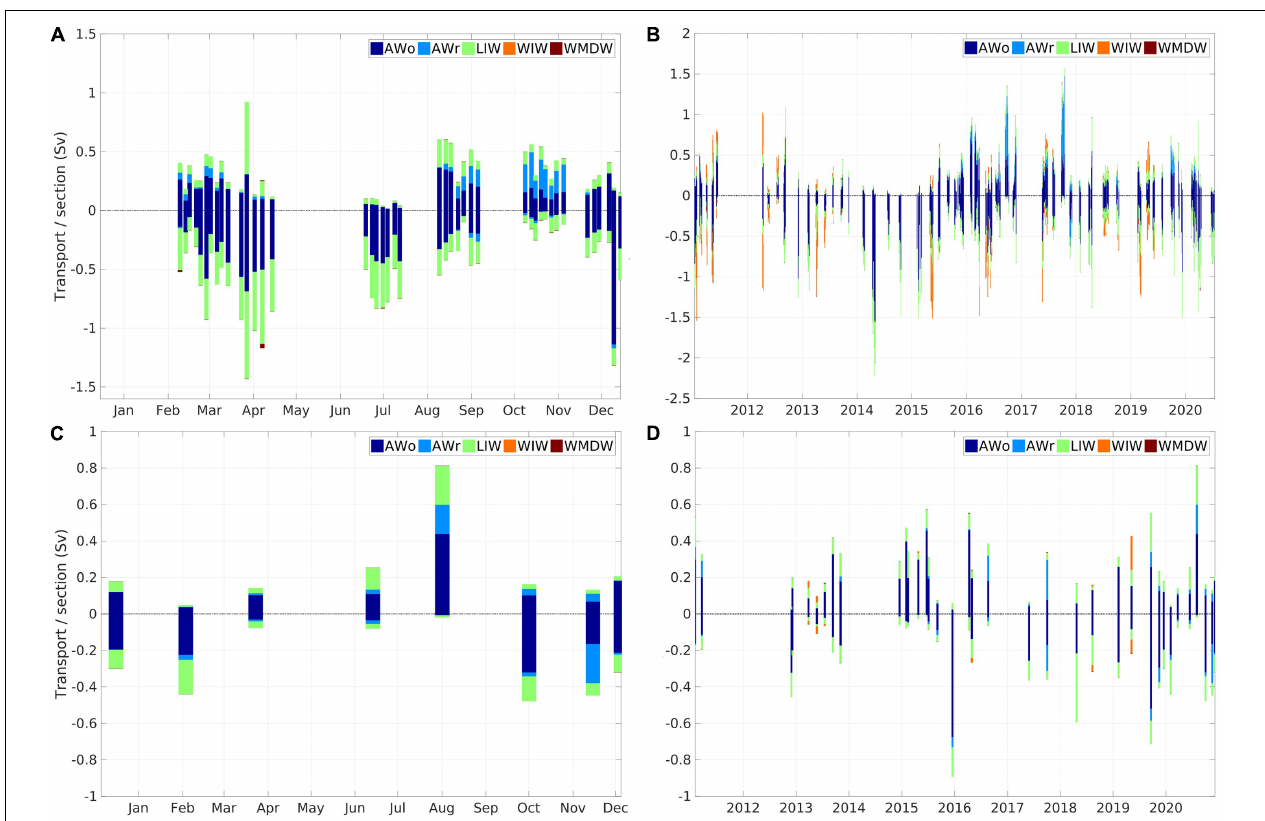
FIGURE 10 | Water mass transports in the IC (A,B) and MC (C,D) for the last year (A,C) and over all the available period since 2011 (B,D) . Each bar correspond to the transport integrated over one completed transect (around 3-day duration). Colors are associated with typical water masses of the WMED: recent and modified AW (light and dark blue, respectively), WIW (orange), LIW (green), and WMDW